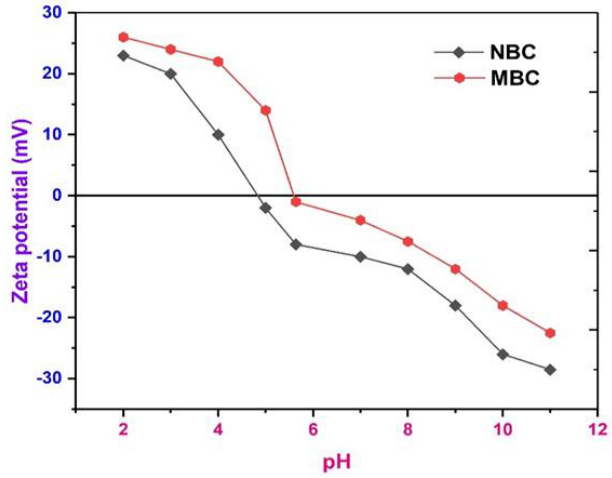
Figure 7. Zeta potential of NBC and MBC at different pH.